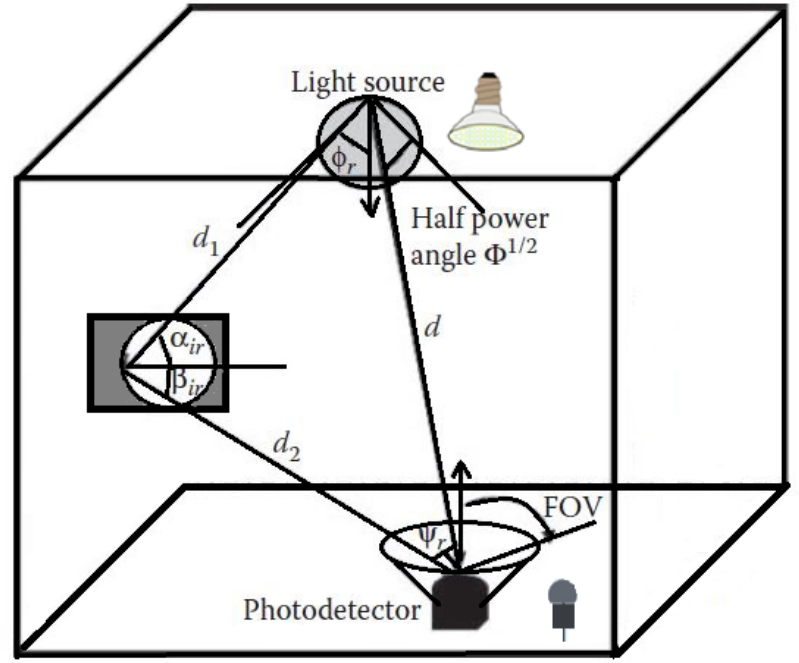
Figure 7. VLC system model with a single reflection wall and LED is placed on the room